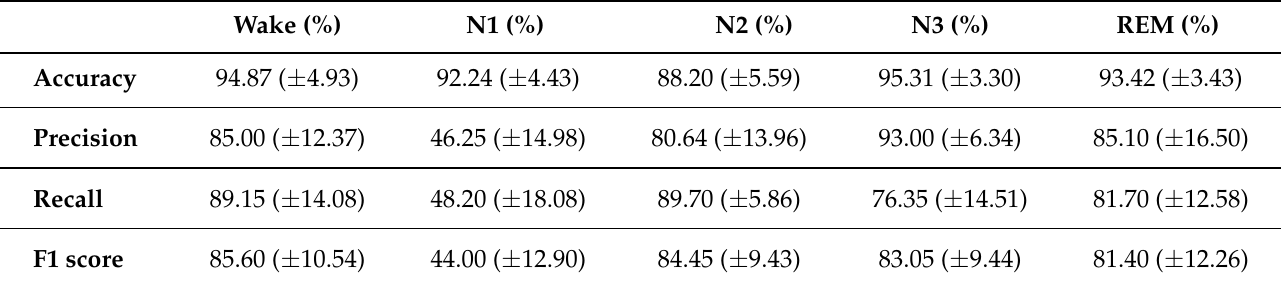
Table 1. Evaluation of DeepSleepNet using the Wisconsin Sleep Cohort